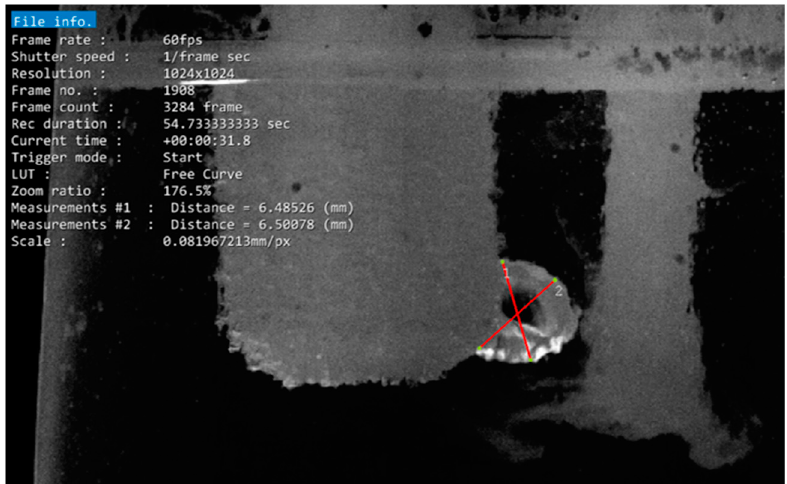
Figure A1. An example of measurement of the bubble diameter during electrolysis using the horizontal anode at current density 0.7 A cm − 2 . The average value was used.